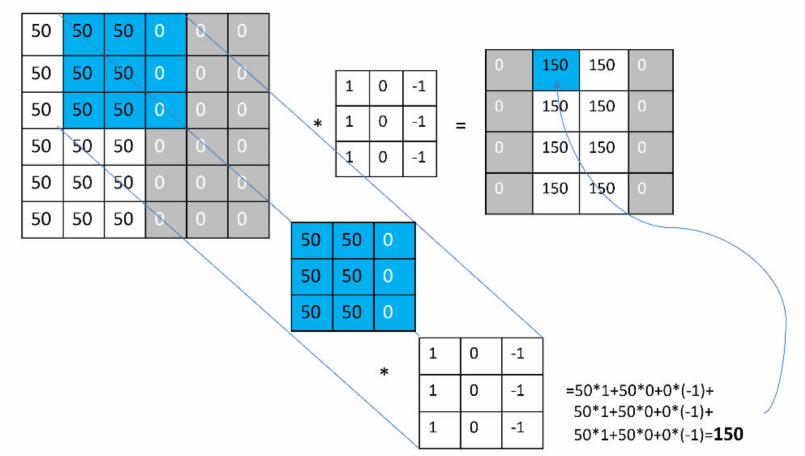
Figure 7. An example of the performance of a vertical filter for a 6 × 6 pixel image. Source: generated by the authors.